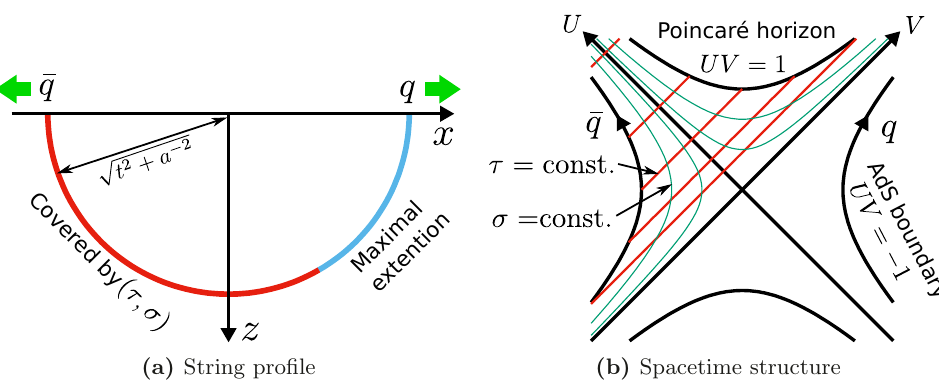
Figure 1. (a) String profile of the holographic EPR pair for a fixed time slice. It is given by the semicircle whose radius is time-dependent. Endpoints of the string corresponds to the quark and antiquark. (b) Spacetime structure of the string worldsheet. Two time-like boundaries correspond to the quark and antiquark. They are causally disconnected but connected by the Einstein-Rosen